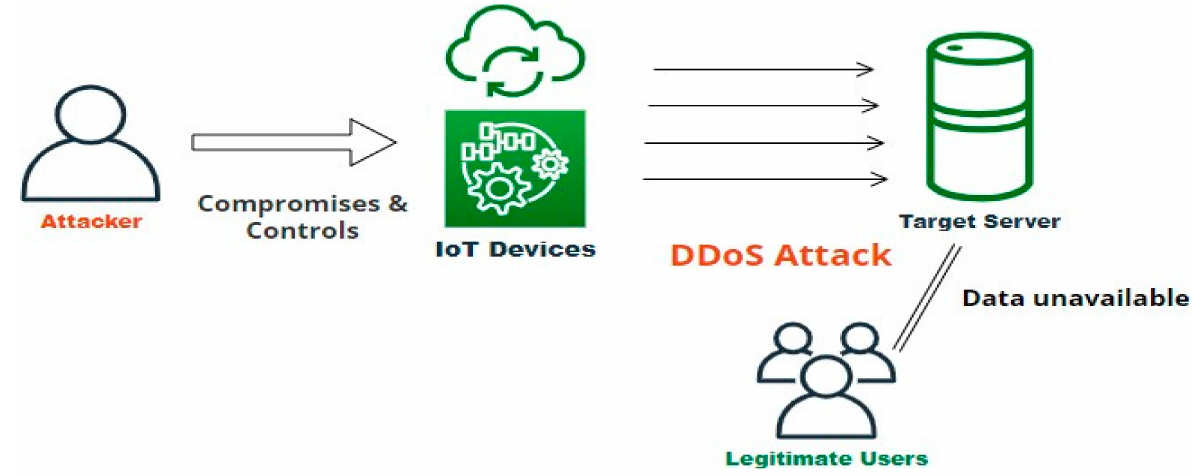
Figure 7. DDoS attack in IoT